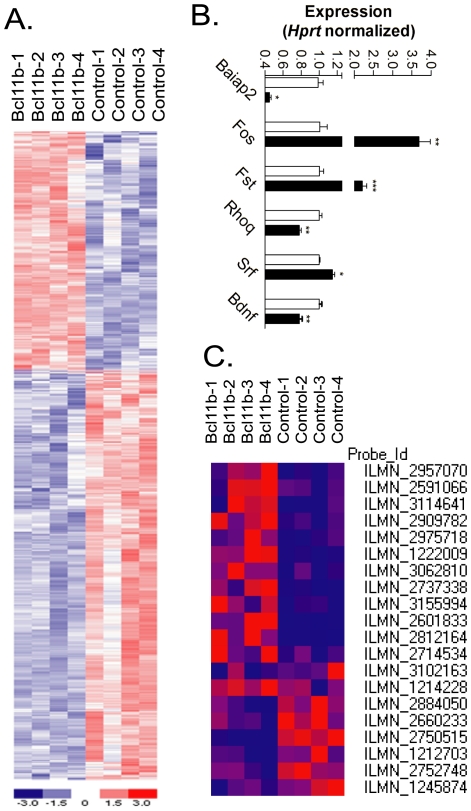
A. Heatmap depiction of the top 693 genes (FDR<0.10) differentially expressed in response to Bcl11b overexpression in striatal cells.Data are from n = 4 different sets of transfected cells. Heatmaps were generated with dChip program (www.dChip.org). Red indicates increased and blue indicates decreased expression relative to the mean transcript expression value. B. Real-time PCR validation of microarray expression differences elicited by Bcl11b in striatal cells. The genes are indicated by their official UniGene ID. Hprt was used to normalize gene expression differences. Open bars represent mock-transfected striatal cells, closed bars represent Bcl11b-transfected striatal cells. Asterisks denote significant differences in Bcl11b-transfected striatal cells compared to mock-transfected cell, as determined by ANOVA *, p<0.05; **, p<0.01; ***, p<0.001. C. Heatmap expression changes of genes related to the BDNF signaling pathway.